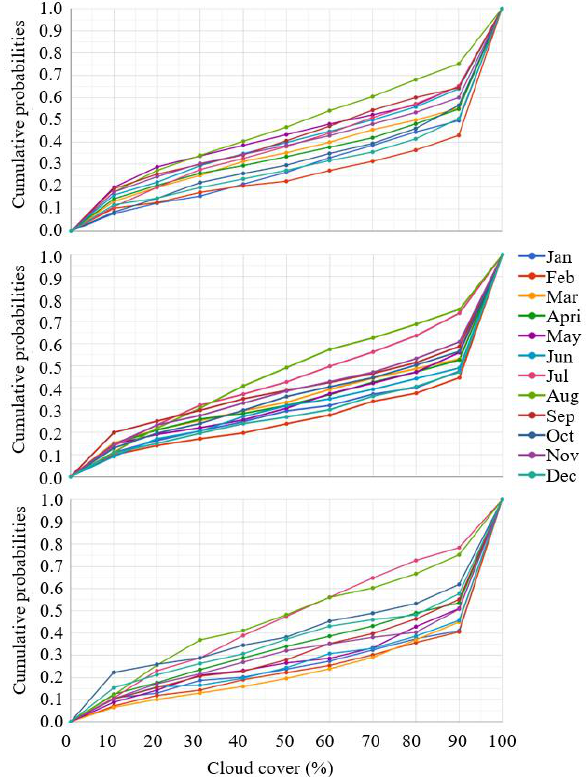
Figure 2. The cumulative average monthly acquisition probabilities (APs) of different CC thresholds range from 0– 100% for all Landsat scenes of TM, ETM+, and OLI sensors in